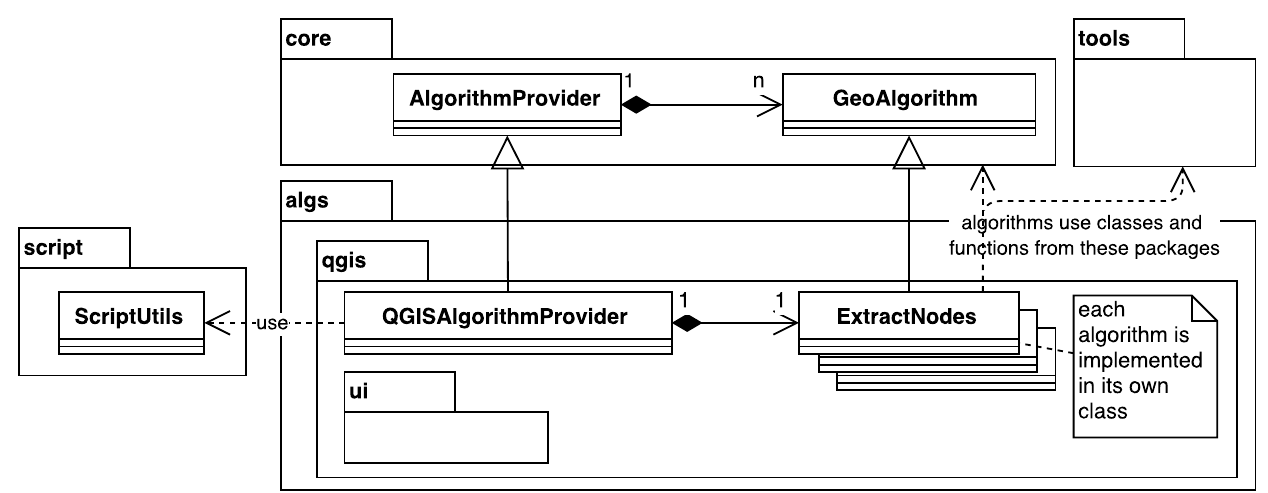
Figure 9. Class diagram of the qgis package and its connections to other